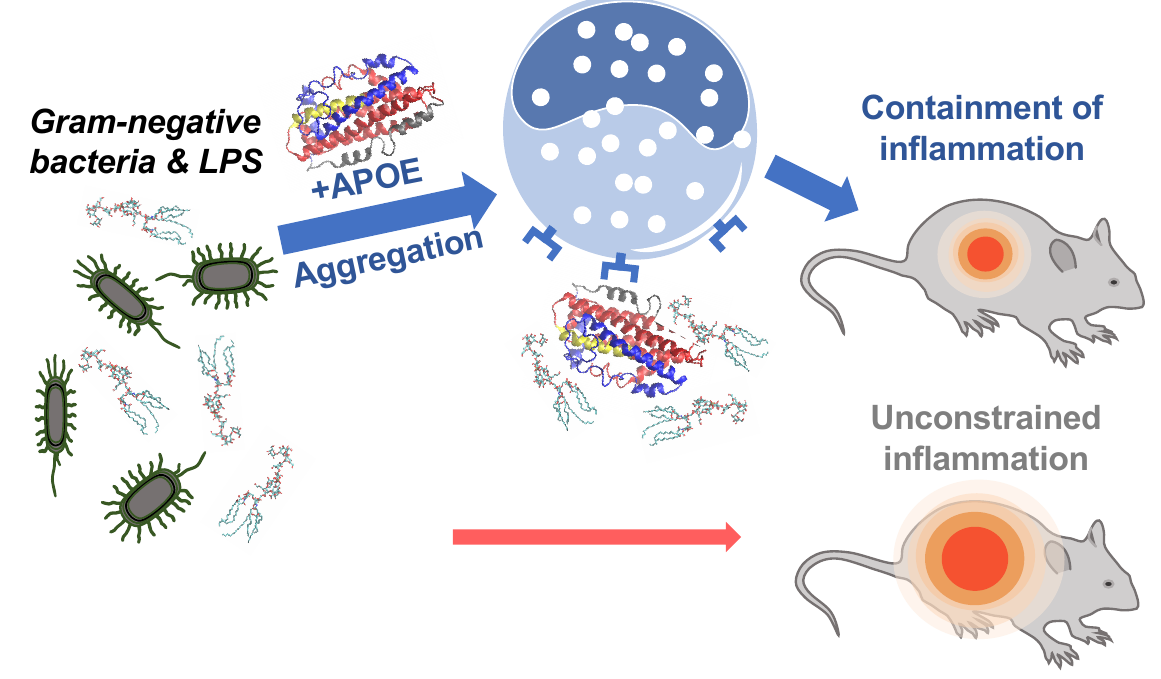
Figure 9. Summary of APOE function. Neutralizing effect of APOE on Gram-negative bacterial infection in vivo.